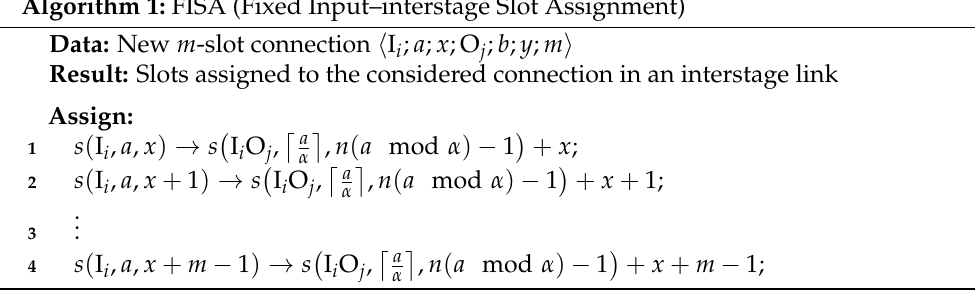
Algorithm 1: FISA (Fixed Input–interstage Slot